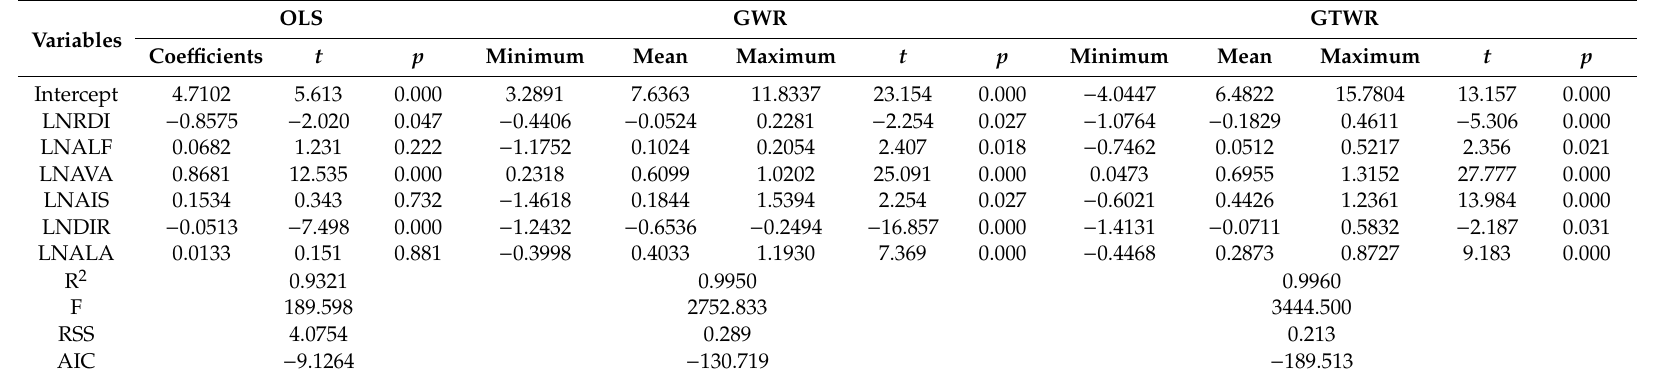
Table 5. The comparison of the parameter estimation of OLS, GWR, and